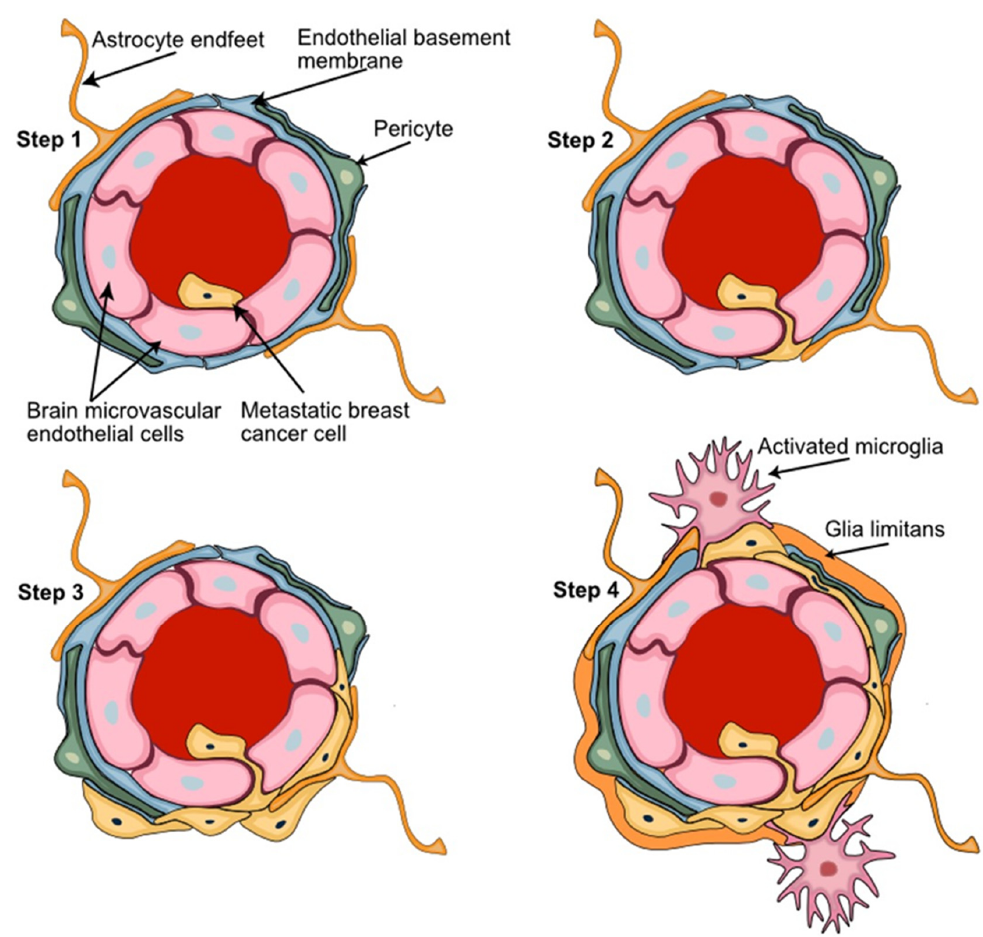
Figure 4. Key steps of the breast-to-brain metastatic process . ( Step 1 ) Adhesion of the metastatic circulating breast cancer cells to the brain microvascular endothelial cells; ( Step 2 ) BBB passage of metastatic cells leaving the circulation by transendothelial migration; ( Step 3 ) adaptation and proliferation of the metastatic cells in their new perivascular niche; ( Step 4 ) establishment of the tumor microenvironment with metastatic breast cancer cells interacting with the key NVU cellular partner pericytes, astrocytes, and microglia . Astrocyte foot processes associated with the parenchymal basal lamina form the outermost layer of central nervous tissue known as glia limitans.